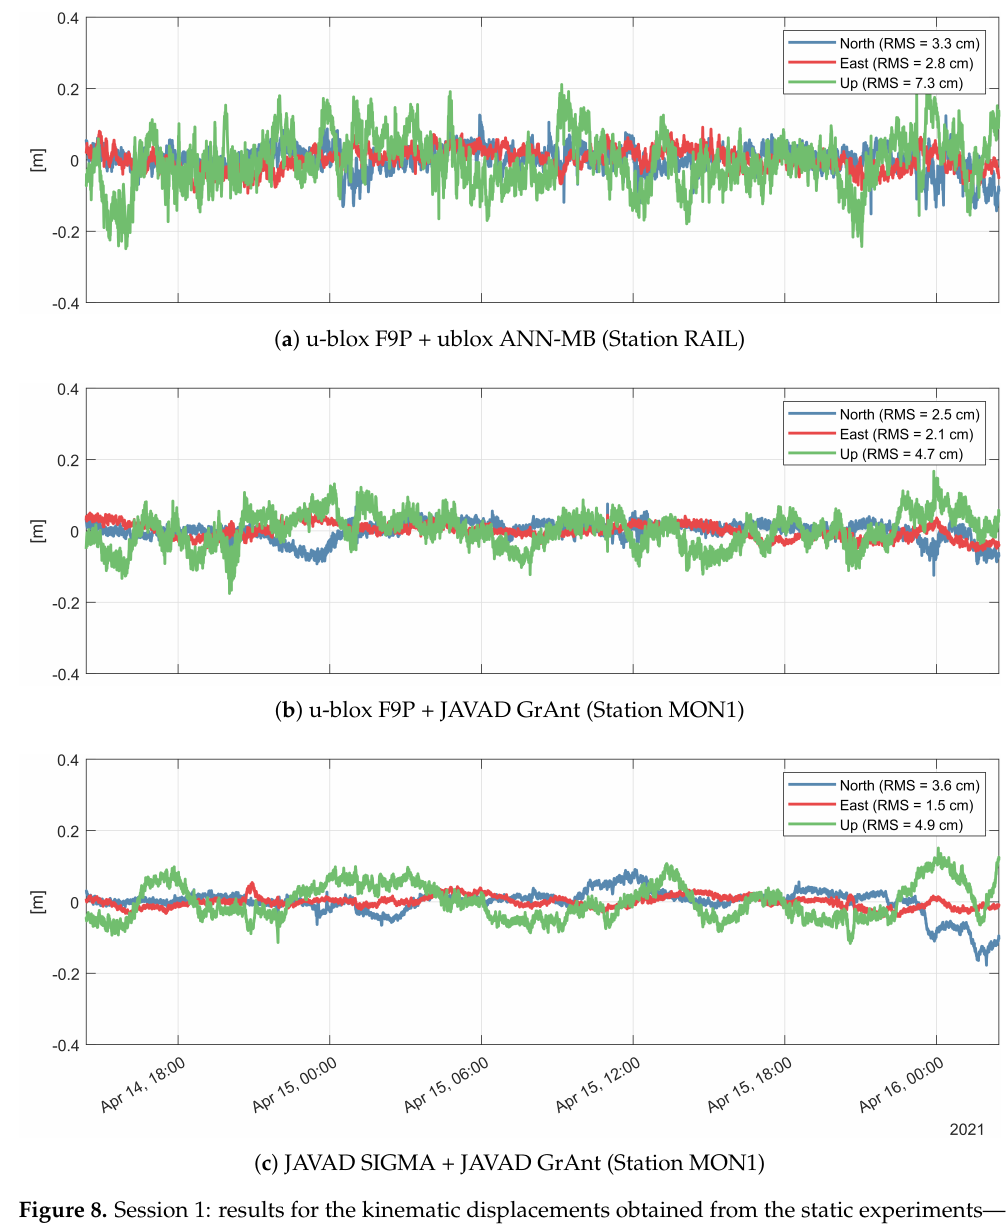
Figure 8. Session 1: results for the kinematic displacements obtained from the static experiments— ambiguity-float solutions computed with